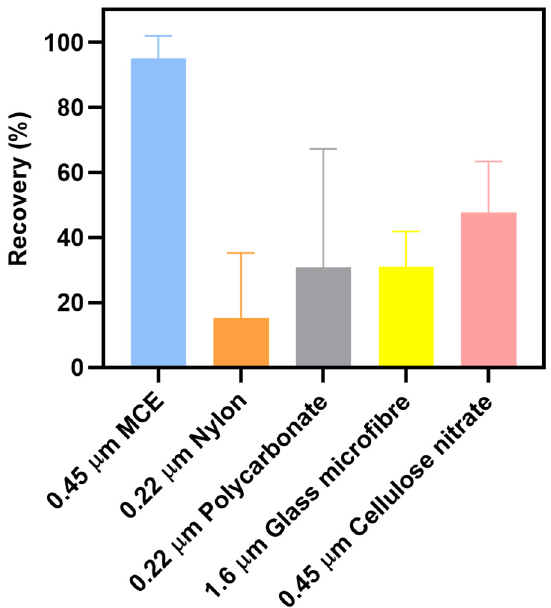
Figure 7. Recoveries (%) of PS (size ~10 µ m) by filtration in ultrapure water sample using different filter membranes.